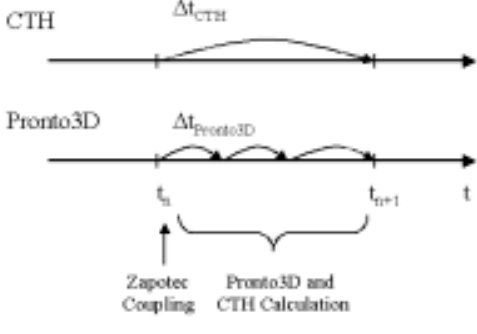
Fig. 1. Time synchronization of CTH and